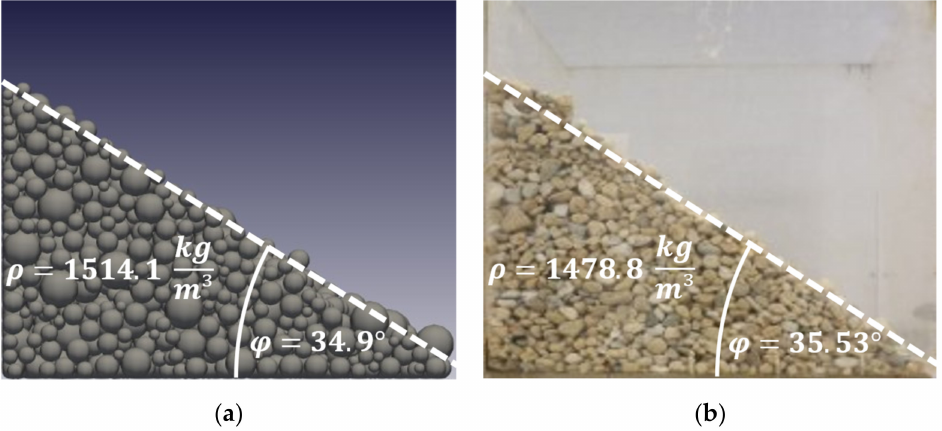
Figure 17. Validation of the identified set of parameters. ( a ) Simulated bulk material; ( b ) real bulk